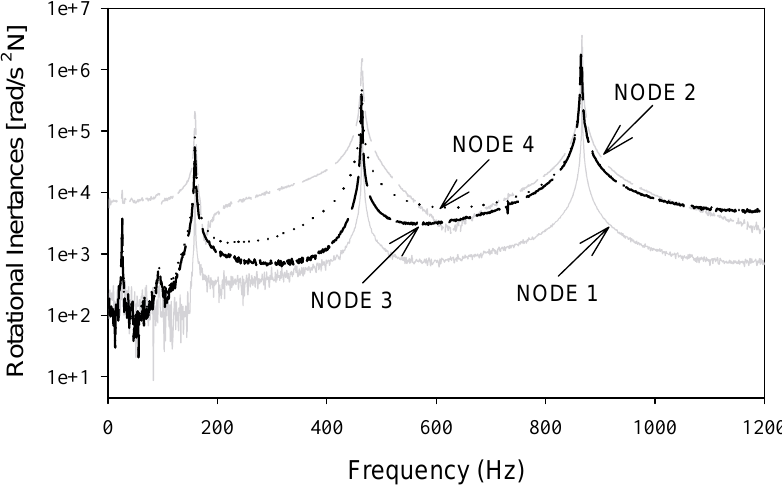
Fig. 8. Predicted rotational inertance FRF at nodes 1–4 of the cantilevered beam structure with a